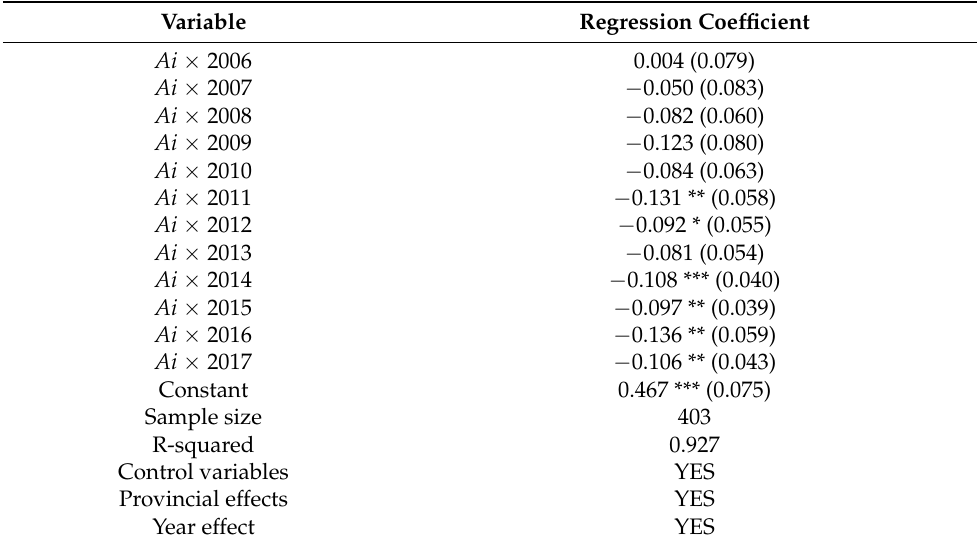
Table 3. Regression results of dynamic policy